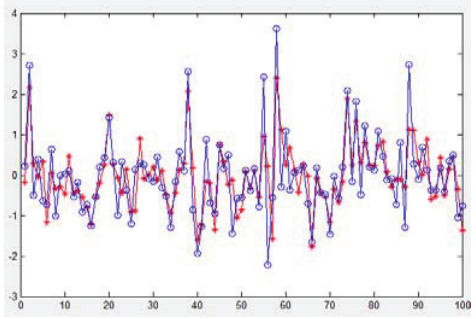
Fig.4 The prediction results of ARMA+SVM